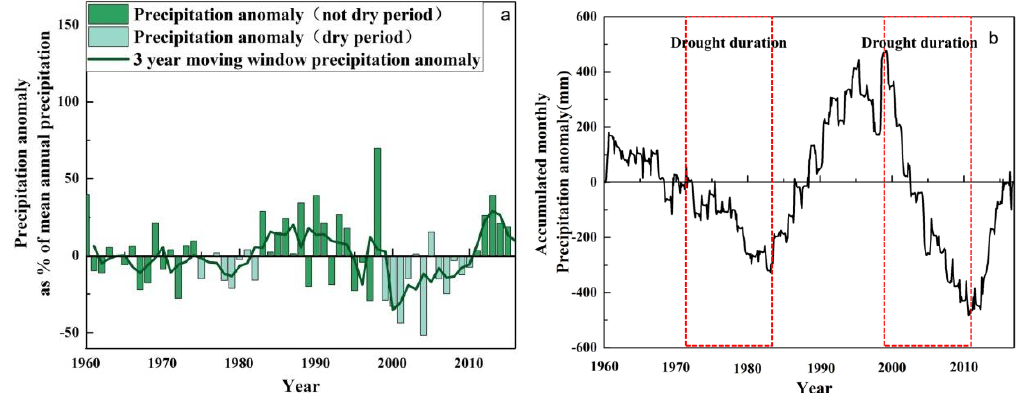
Figure 3. Assessment of meteorological drought events using precipitation anomalies. ( a ) start and end years of meteorological drought; ( b ) exact month of the start and end of the drought period. Table 2. Meteorological (precipitation, P ) and hydrological (streamflow, Q ; baseflow, Q b ) characteristics of the Taoer River basin, the start and end times, duration, intensity, severity, time lags, and the precipitation recovery rate ( P r , calculated as the ratio of the accumulated relative precipitation anomaly between the end of meteorological drought and the end of hydrological drought over the time lag, % per